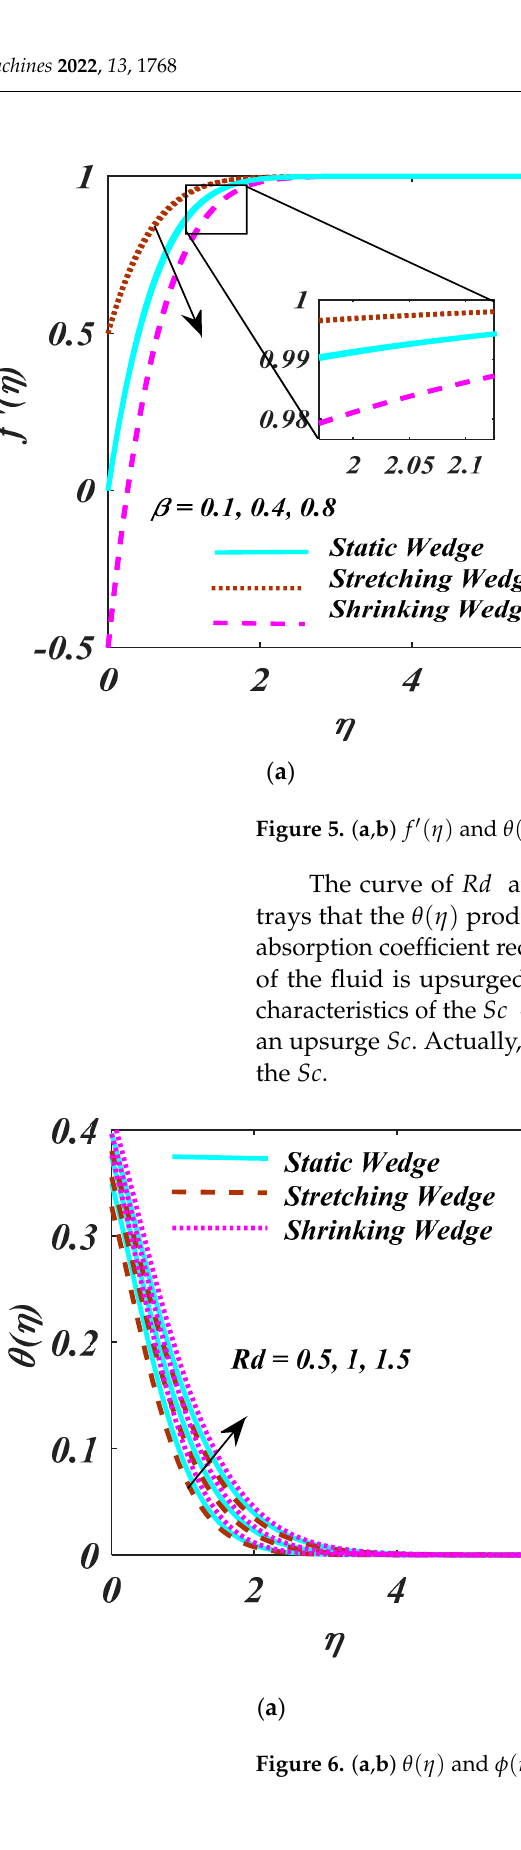
for the rising magnitude of (cid:1840)(cid:1872) , as the (cid:2016)(cid:4666)(cid:2015)(cid:4667) and (cid:2038)(cid:4666)(cid:2015)(cid:4667) inclined, causes extra particles